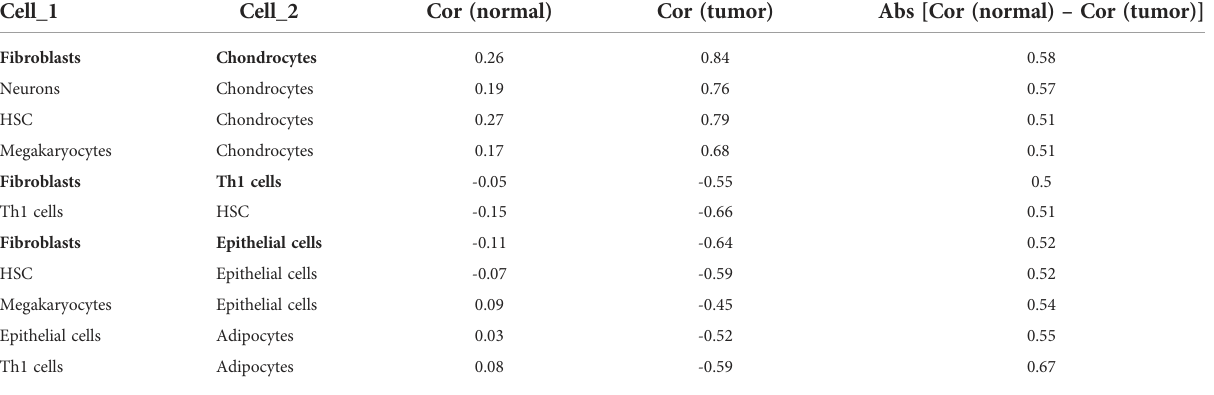
TABLE 1 Correlation coef fi cients between cell types with the change between normal and tumor. greater than 0.5.